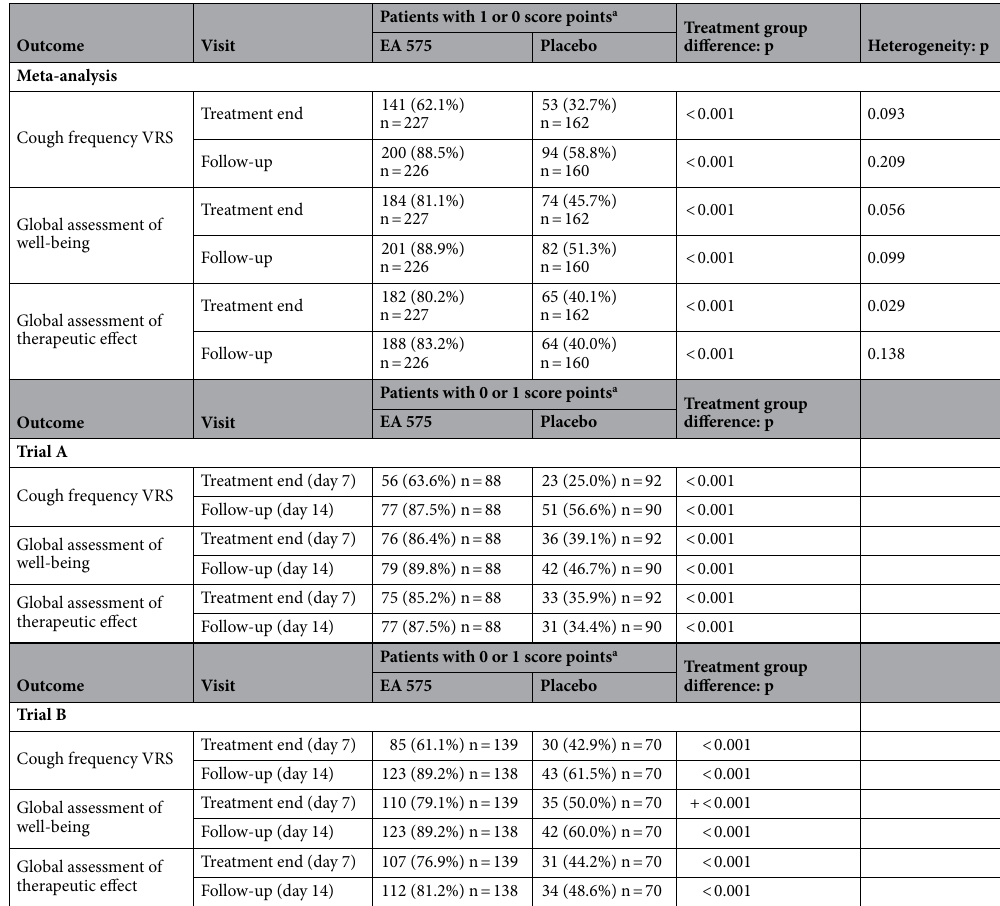
Table 3. Cough intensity/frequency VRS, global self-ratings of well-being and therapeutic effect—meta- analysis and individual trial results (full analysis set; p-values from ordinal logistic regression analysis). VRS Verbal rating scale. a Cough intensity/frequency VRS: 1 = ‘one short, mild period’ or 0 = ‘no cough’; global well- being and efficacy assessment: 1 = ‘well’ or 0 = ‘very